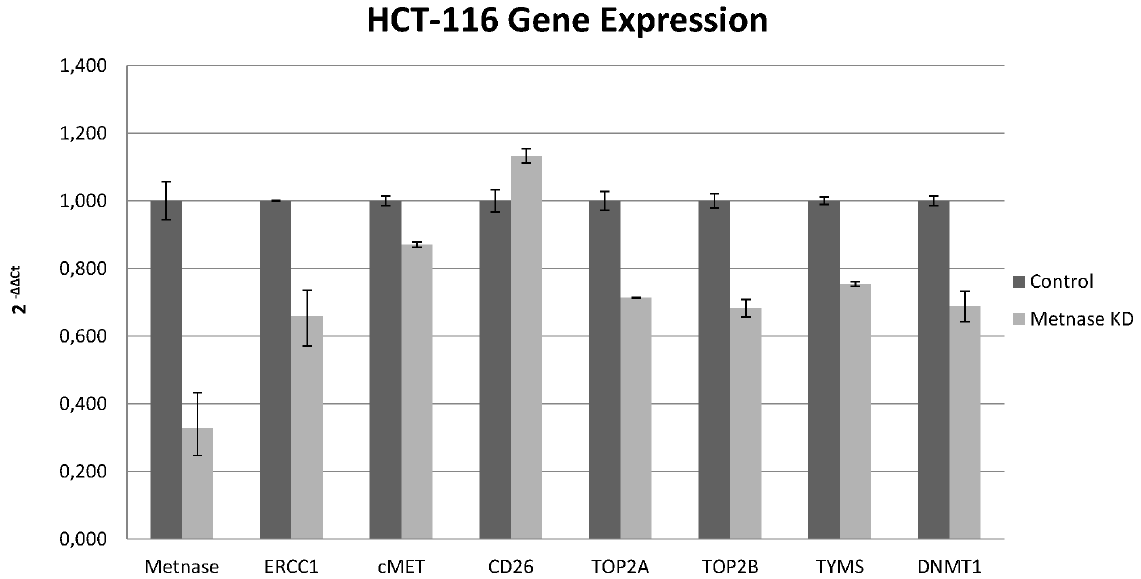
Figure 1. Metnase regulates gene expression in colon CSCs. Relative gene expression of transcription factors in Colon CSCs following Metnase knockdown. The percentage of Metnase knockdown reached 40%. The DD Ct method was used to perform the analysis. Each bar represents the average of the Ct values. The assays were performed in triplicate and a p-value , 0.05 was considered significant. In the control sample the average value is 1.00 indicating that there is no change in gene expression. Values . 1 indicate an increase in gene expression while values , 1